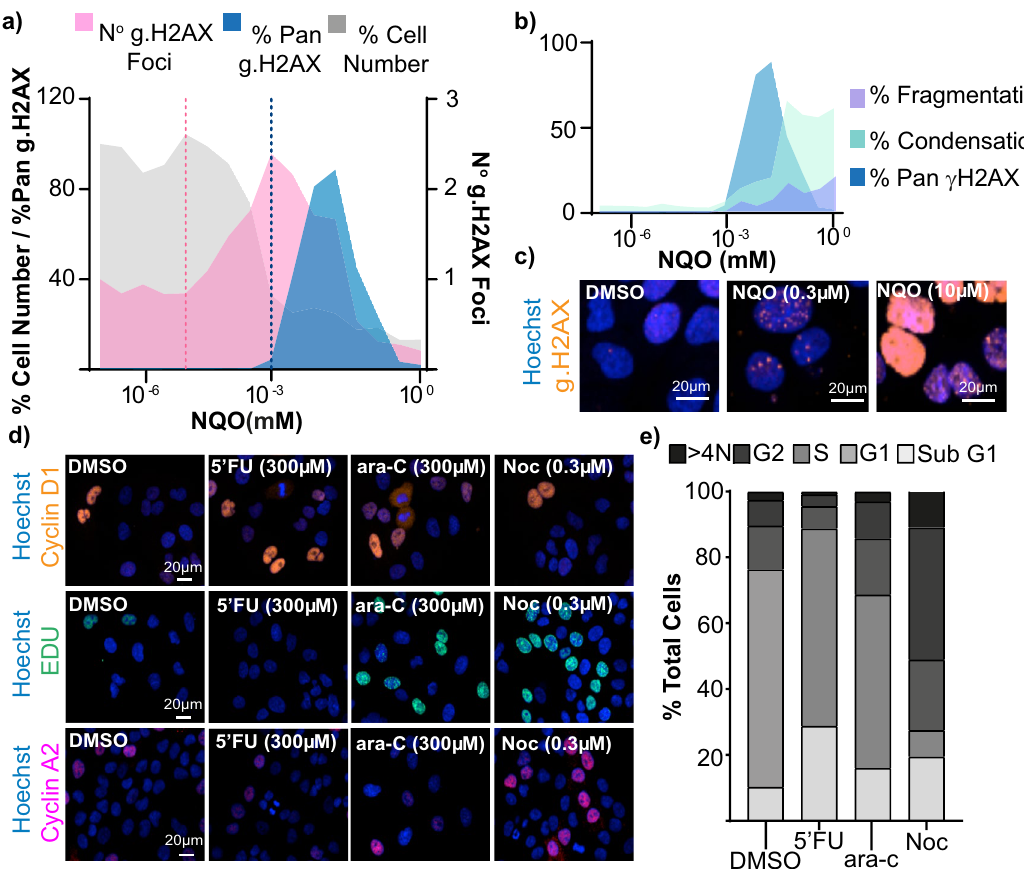
Figure 4. Validation of additional assay endpoints. Effect of A549 cell treatment with increasing concentrations of NQO on γ.H2AX phenotypes. ( a ) Quantification of the % of cells with pan γ.H2AX staining (blue), relative toxicity, illustrated by reductions in cell number (grey) and the average number of γ.H2AX foci per nucleus (pink). Horizontal lines illustrate the dose at which increases in γ.H2AX foci (pink) and % pan γ.H2AX stained cells were initially observed. ( b ) Quantification of the % of cells with pan γ.H2AX staining (blue), and nuclear condensation (green) and fragmentation (purple) phenotypes as indicators of cell death. ( c ) Representative immunofluorescence images of A549 cell nuclei treated with 0, 0.3 µM and 10 µM NQO (scale bar 20 µM), DNA (Hoechst, blue) and γ.H2AX (orange). Validation of use of Hoechst intensity for cell cycle analysis. ( d ) Representative immunofluorescence images of cells treated with DMSO (control), 5-Fluorouracil (5 ′ -FU) (300 µM) Cytarabine (ara-c) (300 µM) and Nocodazole (0.3 µM); DNA (Hoechst, blue) with cyclin D1 (orange) EDU-GFP (green) or Cyclin A2 (pink). ( e ) Cell cycle analysis based on Hoechst intensity analysis of A549 cells treated for 48 h with DMSO (control), 5-Fluorouracil (5 ′ -FU) (300 µM) Cytarabine (ara-c) (300 µM) and Nocodazole (Noc) (0.3